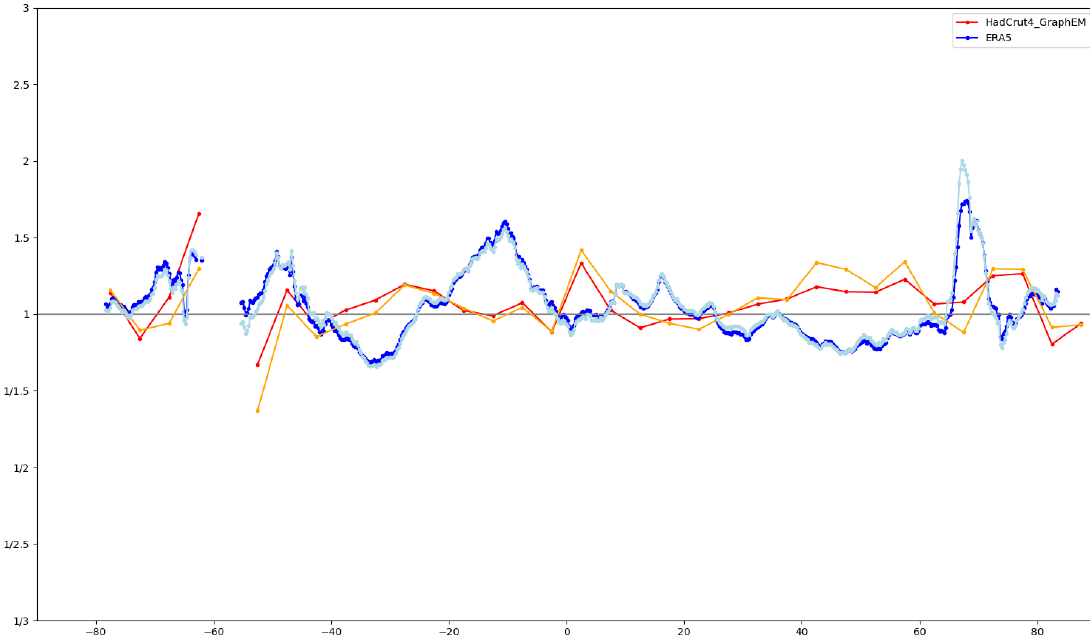
Figure A6. Zonally averaged contrast in observed land–ocean temperature variability as a function of latitude for different observational periods. The full observational period for HadCrut4 (red) is 1850–2013 and is 1979–2019 for ERA5 (dark blue). Shown for comparison are the result for HadCrut4 (orange) and ERA5 (light blue) when only the period of overlap is used in the calculations (1979–2013). Note that the y -axis scale in the right-hand panel is non-linear, with for instance 1 / 1 . 5 or 1 / 2, meaning that there is 50% or 100% more variability over the ocean than there is over the continents.